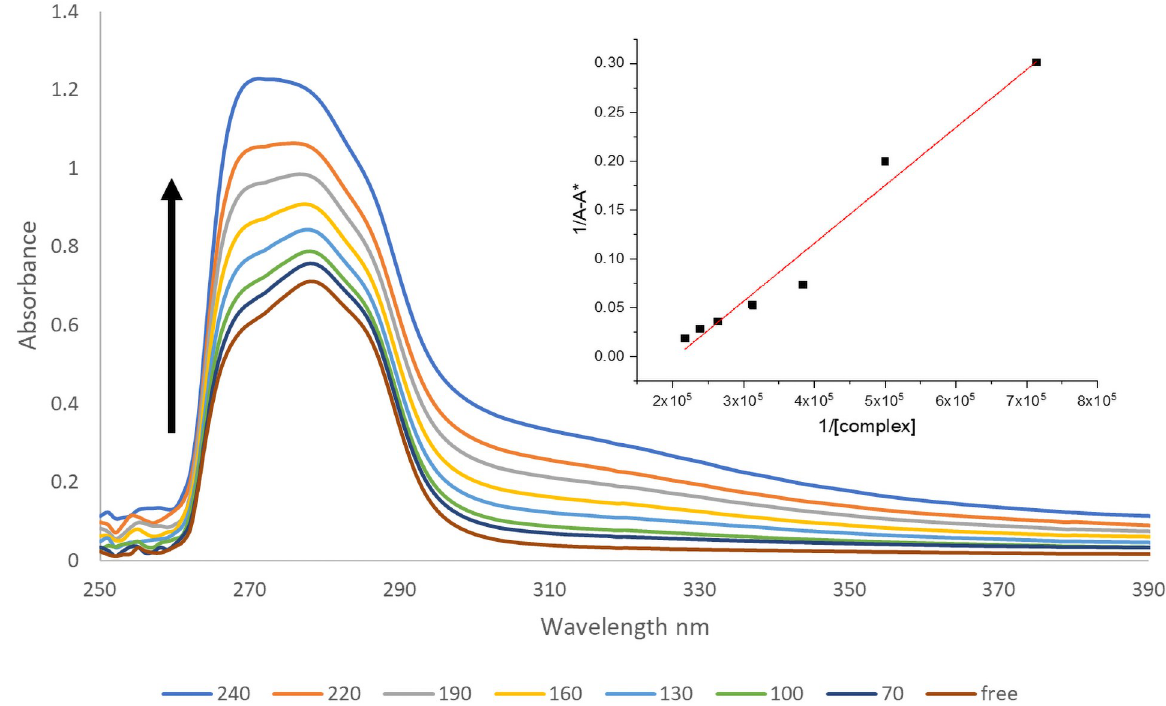
Fig 9. Absorption spectra of HSA in the absence and presence of increasing amounts of [(UO 2 )(OAc) 2 (MP)] complex, indicated by the